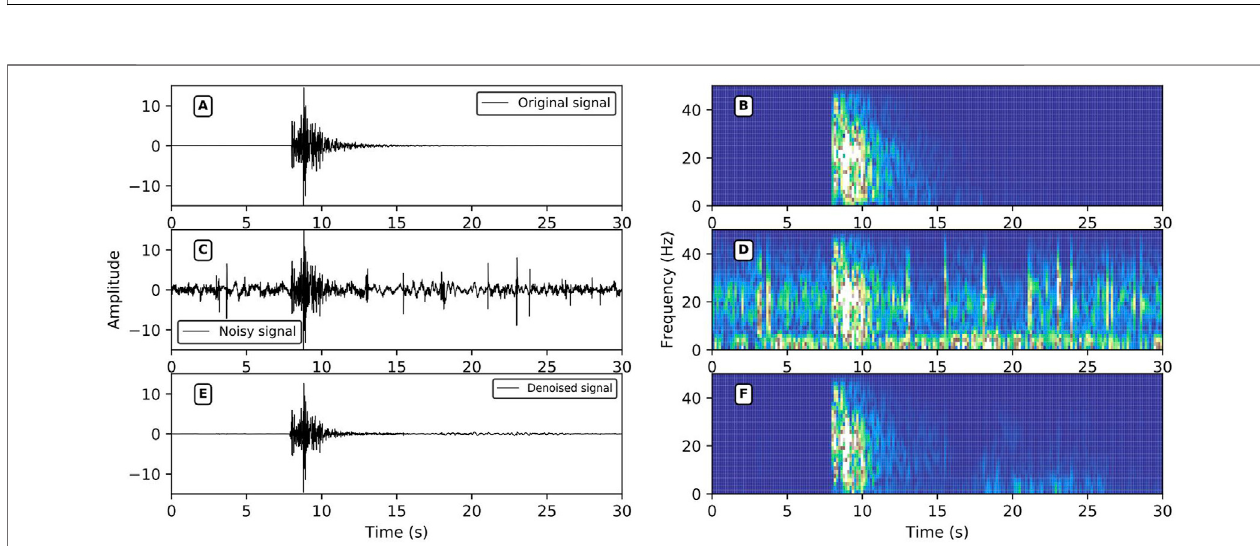
FIGURE 11 | Spike noise reduction performance. (A,C,E) are the original signals, the noise signal, and the signal after noise reduction in the time domain; (B,D,F) are the time-frequency domain data of (A,C,E) ; the signal SNR after adding noise (cid:1) 0.01 dB, r (cid:1) 0.7013, SNR after noise reduction (cid:1) 10.02 dB, r (cid:1) 0.9578.